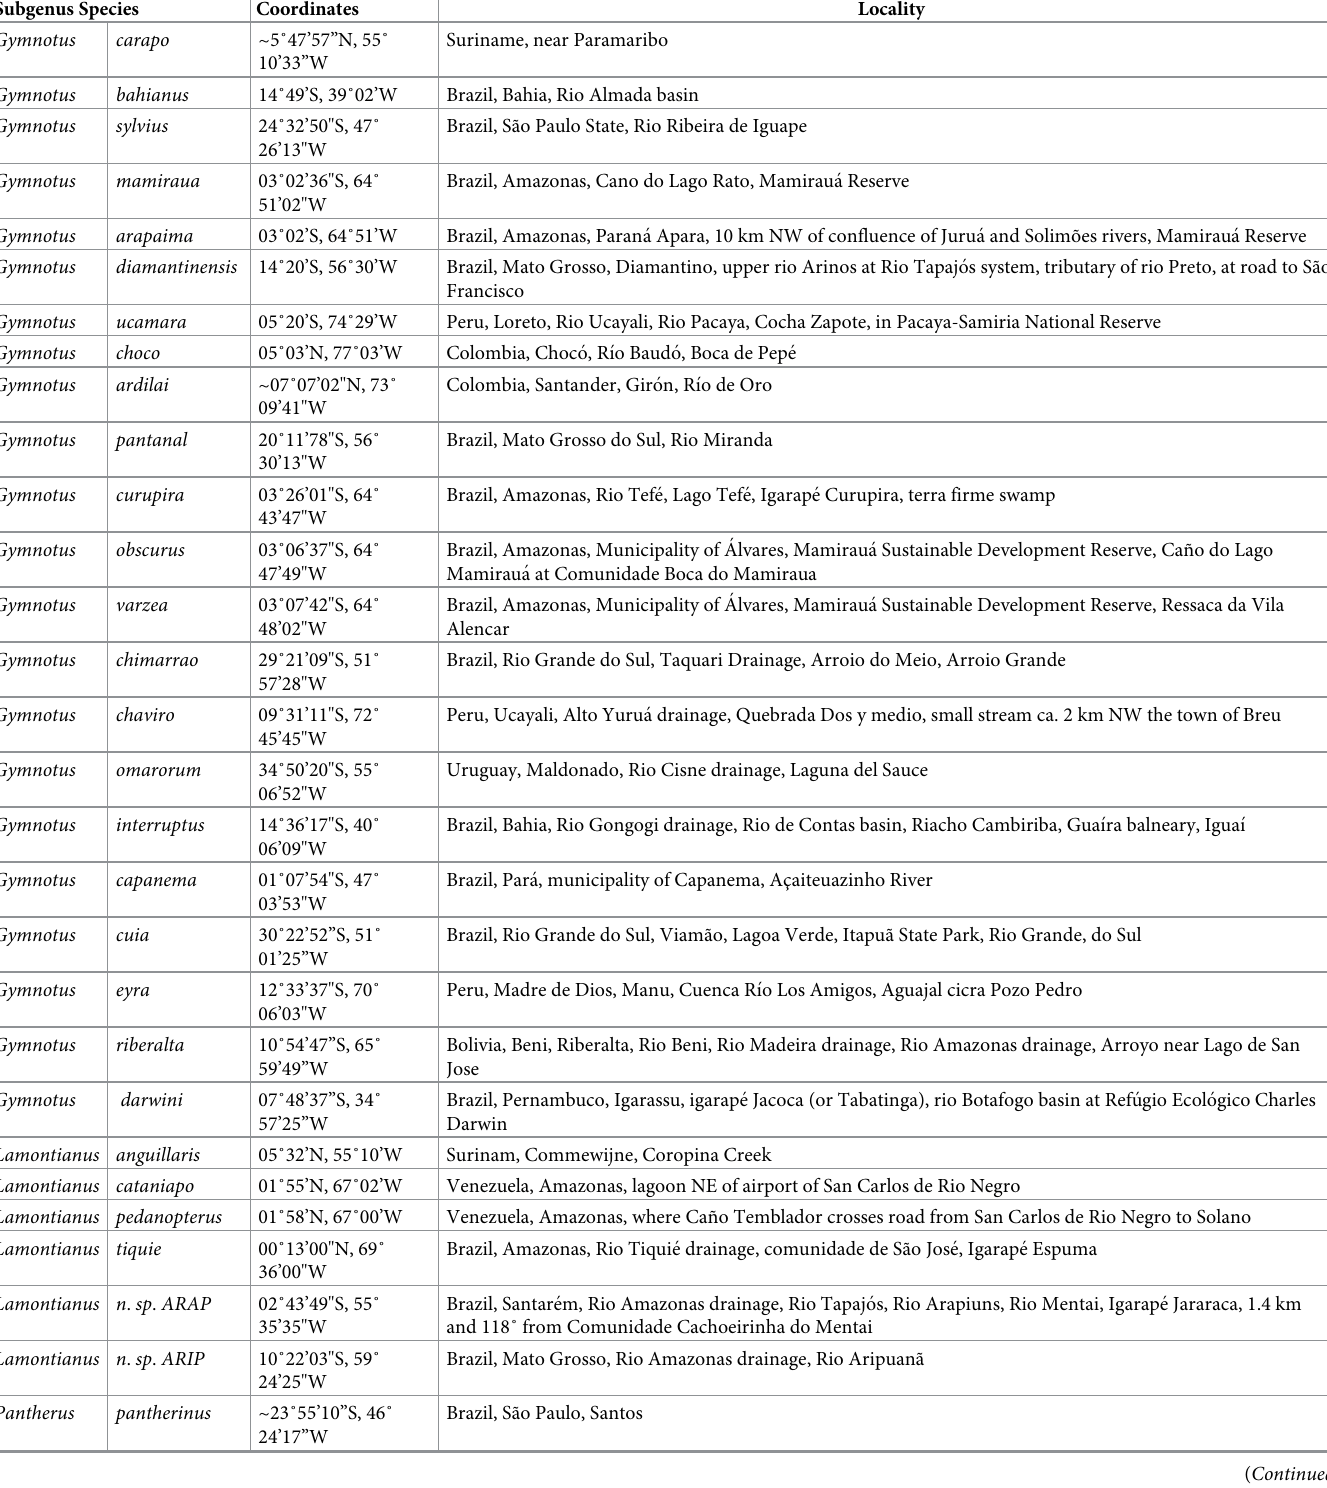
Table 2. Type localities of all valid gymnotine species. In cases where geographical coordinates were not included in the original description, estimates are provided indicated by “~”. Subgenus